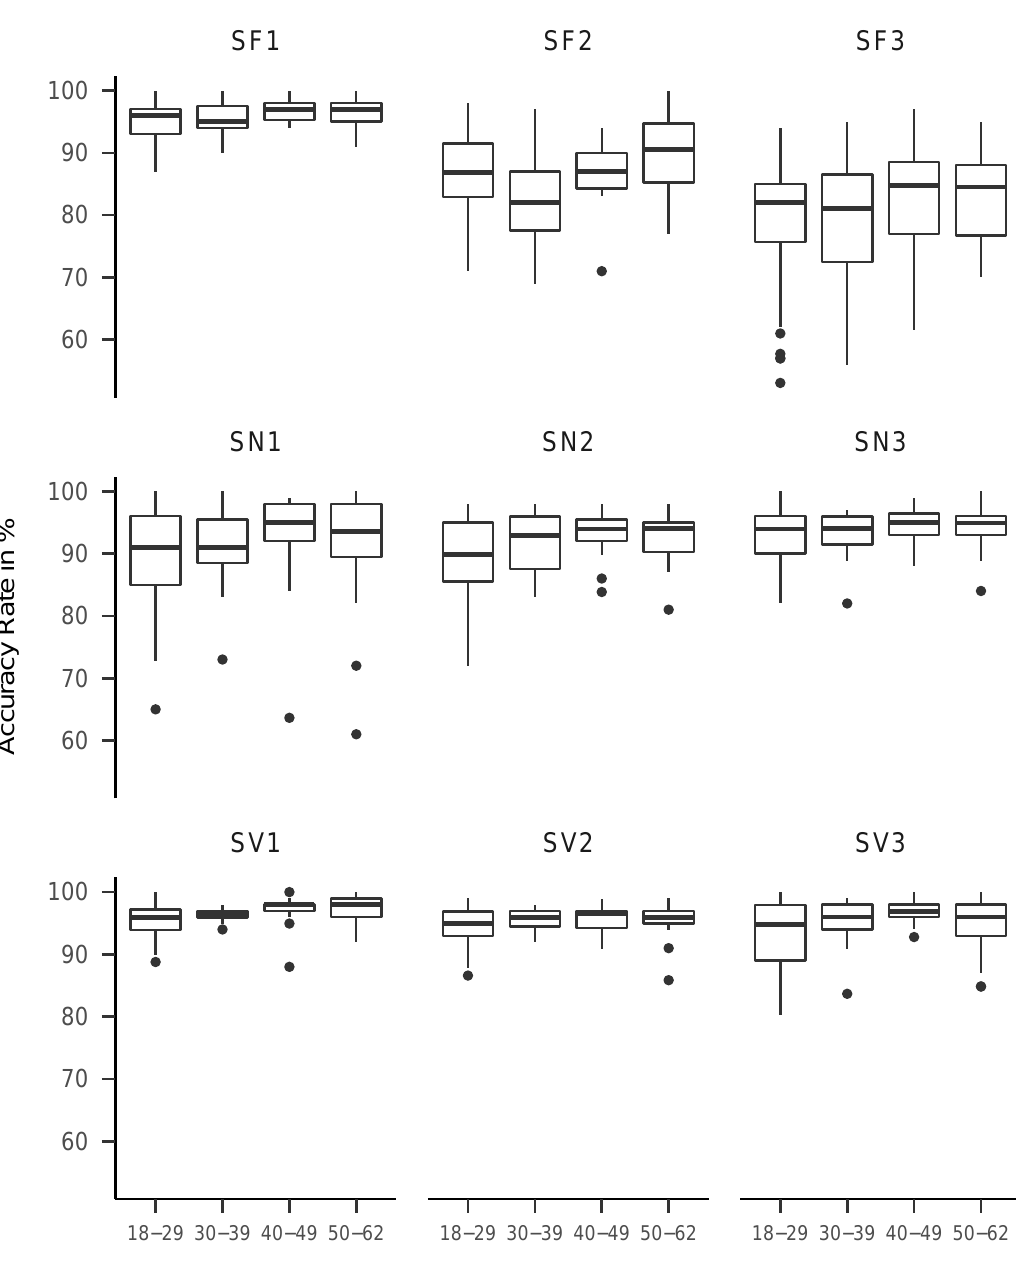
Figure A4. Boxplots of accuracy rates for all slow tasks, split by age groups. See Table 1 for an explanation of the task